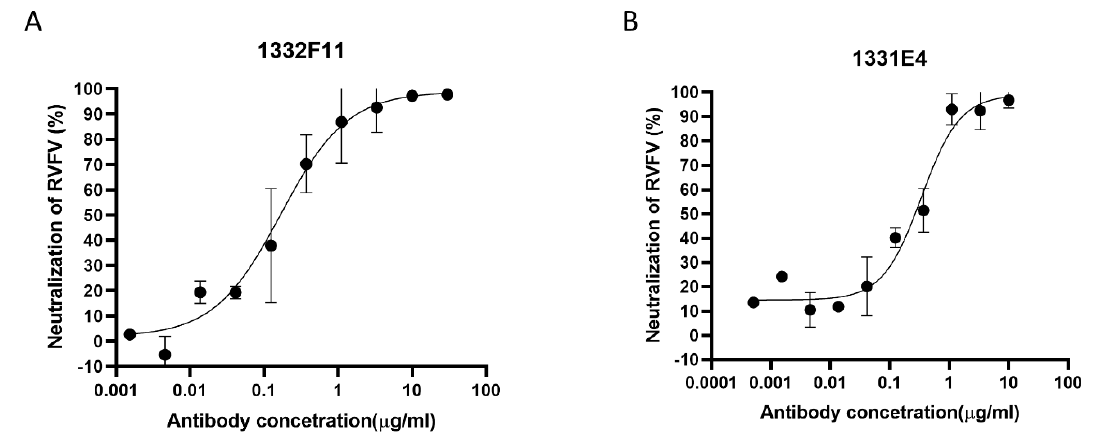
Figure 2. Protection efficacy of monoclonal antibodies against RVFV infection in Huh7 cells. ( A , B ) RVFV MP-12 strains expressing Renilla luciferase (RVFV-SRluc) amplified in Huh7 cells were mixed with threefold serial dilutions of the indicated neutralizing antibodies (NAbs). The luciferase activity (Luc) was measured via the Renilla luciferase assay system. The neutralization of RVFV (%) was calculated as (1 − Luc measured / Luc virus control ) × 100. Sigmoid neutralizing curves were generated through GraphPad Prism 8. Experiments were repeated three times, and the representative results are presented.